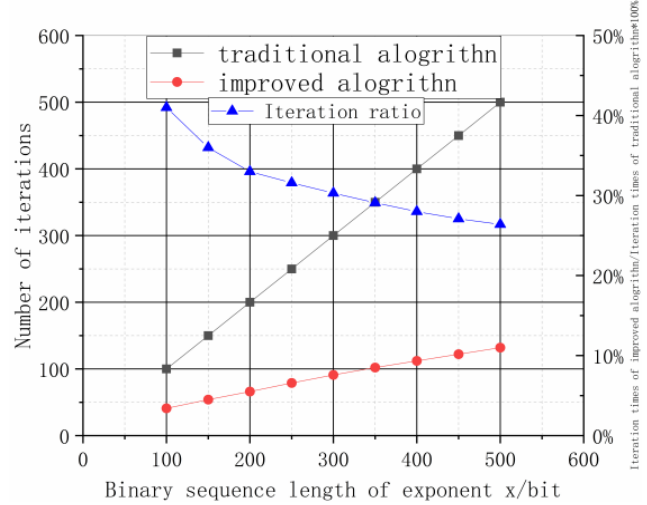
Figure 8. Experimental results of algorithm efficiency.